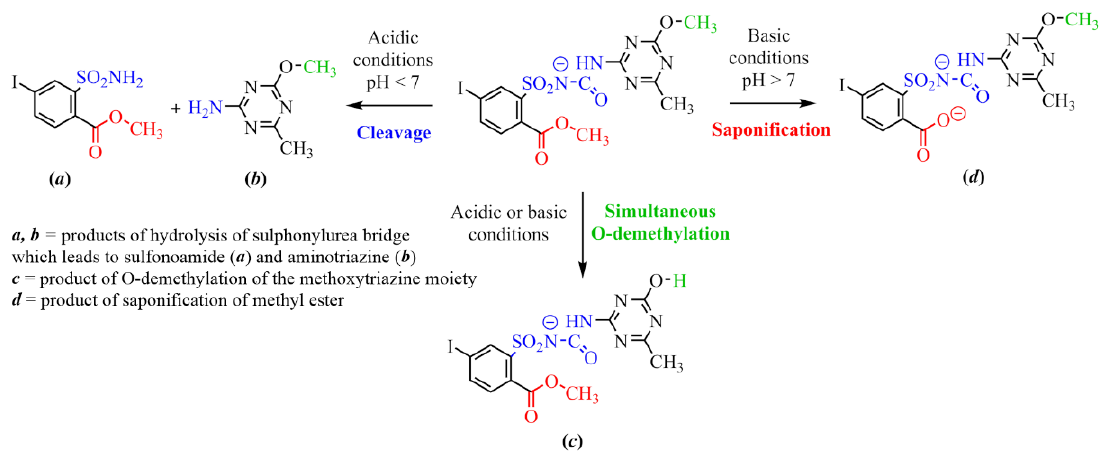
Figure 4. UV spectra of iodosulfuron-methyl sodium salt ( [Na][ISM] ) and IL 4 in acidic ( A ), neutral ( B ) and basic ( C )